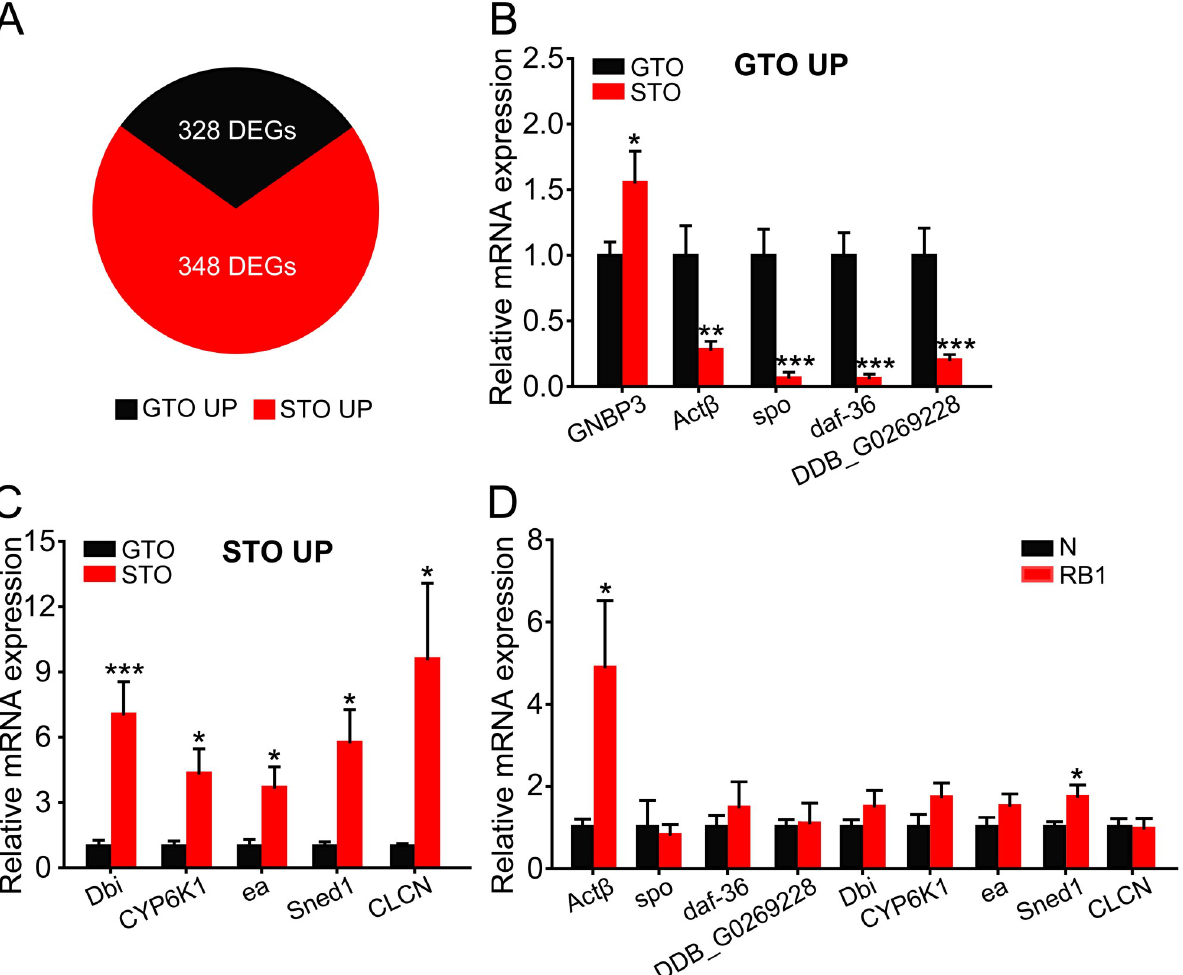
Fig 2. Transcriptomic analyses of gregarious (G) and solitarious (S) terminal oocytes (TO). (A) The number of differentially expressed genes between GTO and STO. (B and C) qRT-PCR verification of the top 5 genes upregulated in GTO (B) or STO (C). n = 7–12. (D) The expression levels of nine verified genes at N and RB1 stages. n = 4–7. � P < 0.05, �� P < 0.01, ��� P < 0.001.